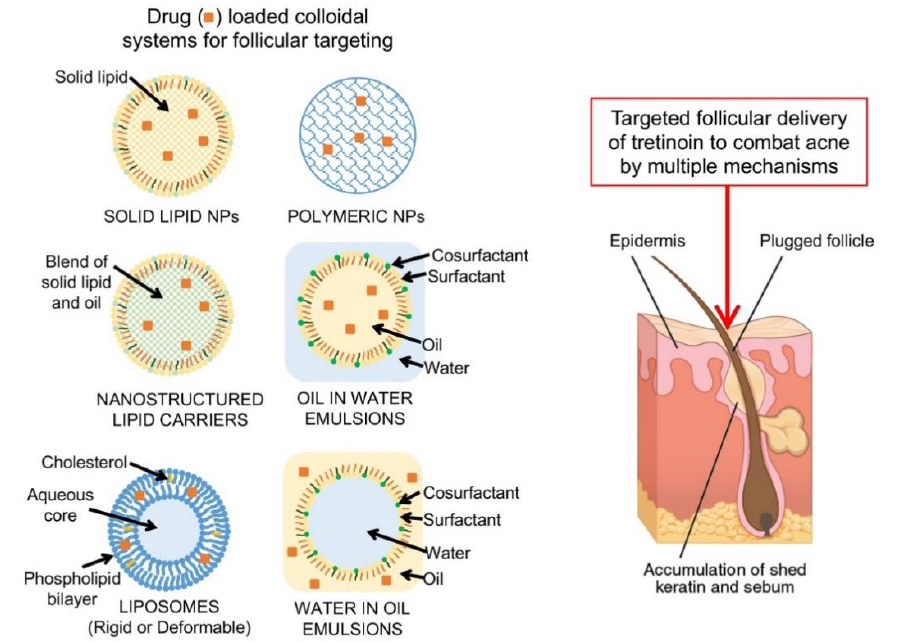
Figure 2. Nanosystems evaluated for the targeted delivery of retinoids to the skin tissues and